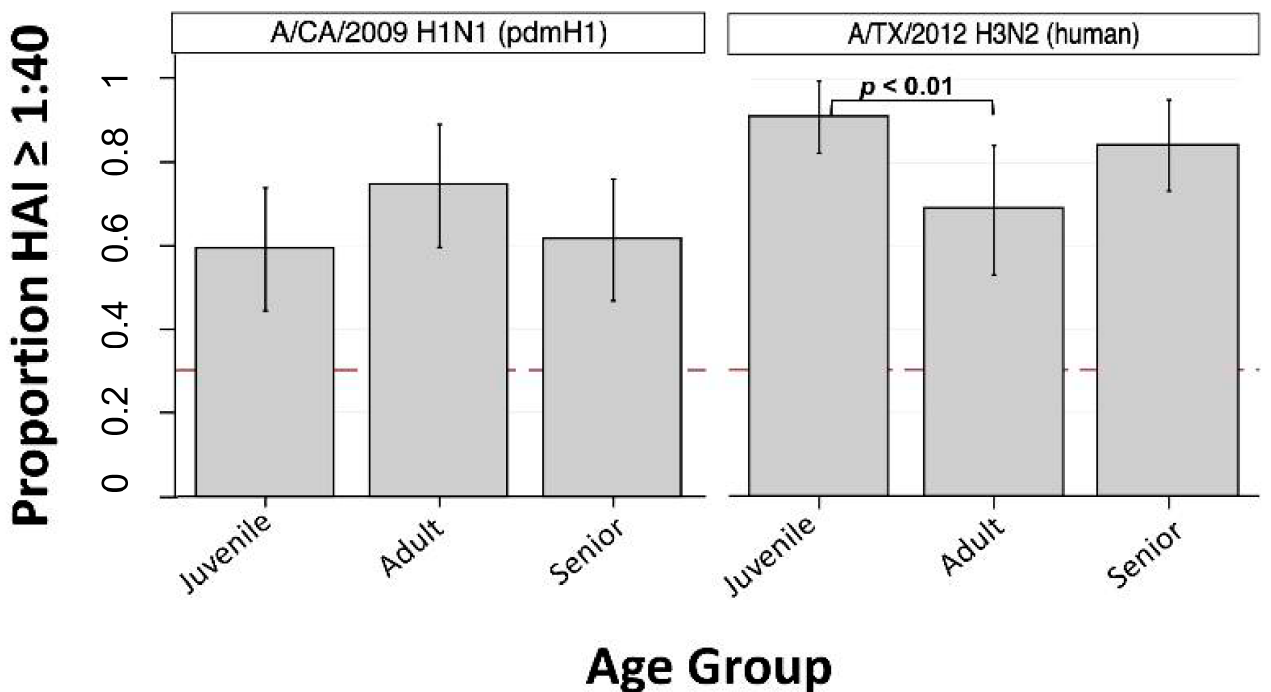
Figure 4. Seroprotection rate (SPR) against pdmH1 and H3 human seasonal IAVs by age group ( n = 3). Bar height indicates proportion of individuals with HAI antibody titer >1:40, the seroprotection rate (SPR) within Juvenile (<18 years old), Adult (18 to 49 years old), and Senior ( ≥ 50 years old) age groups. Dashed red line at y = 0.3 corresponds to SPR of 30%. Vertical spikes and caps indicate 95% confidence interval of the proportion. Significant difference in proportions between groups are indicated (when present) by horizontal brackets and p -values (Pearson’s chi-squared).